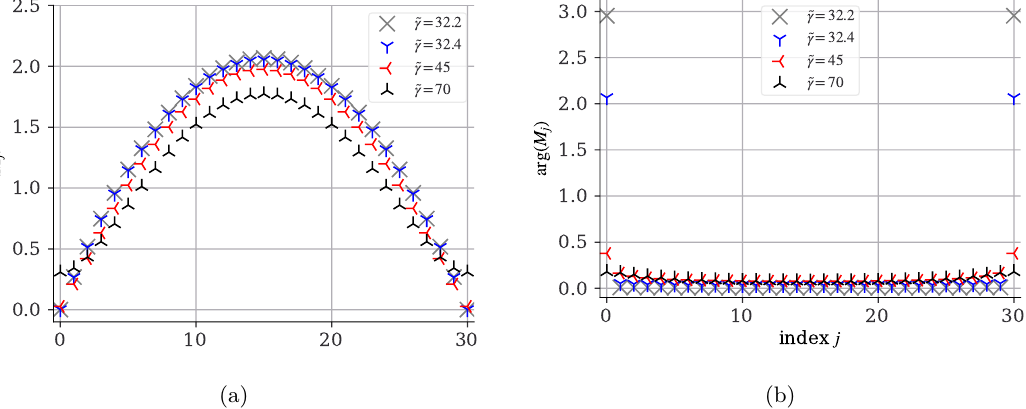
Figure 12. (a) θ = π numerical results for | M j | as functions of j , in the partial phase, at ˜ γ = 32 . 2 (gray crosses) 32 . 4 (blue 3-pont star), 45 (red 3-point star), and 70 (black 3-point star). (b) θ = π numerical results for arg ( M j ) as functions of j , in the partial phase, at the same ˜ γ as in (a). Generically the M j have non-zero phases, indicating spontaneous breaking of CP symmetry. As we decrease ˜ γ we see that arg ( M 0 ) grows, to meet the value of the deconfined phase, arg ( M 0 ) = θ = π .